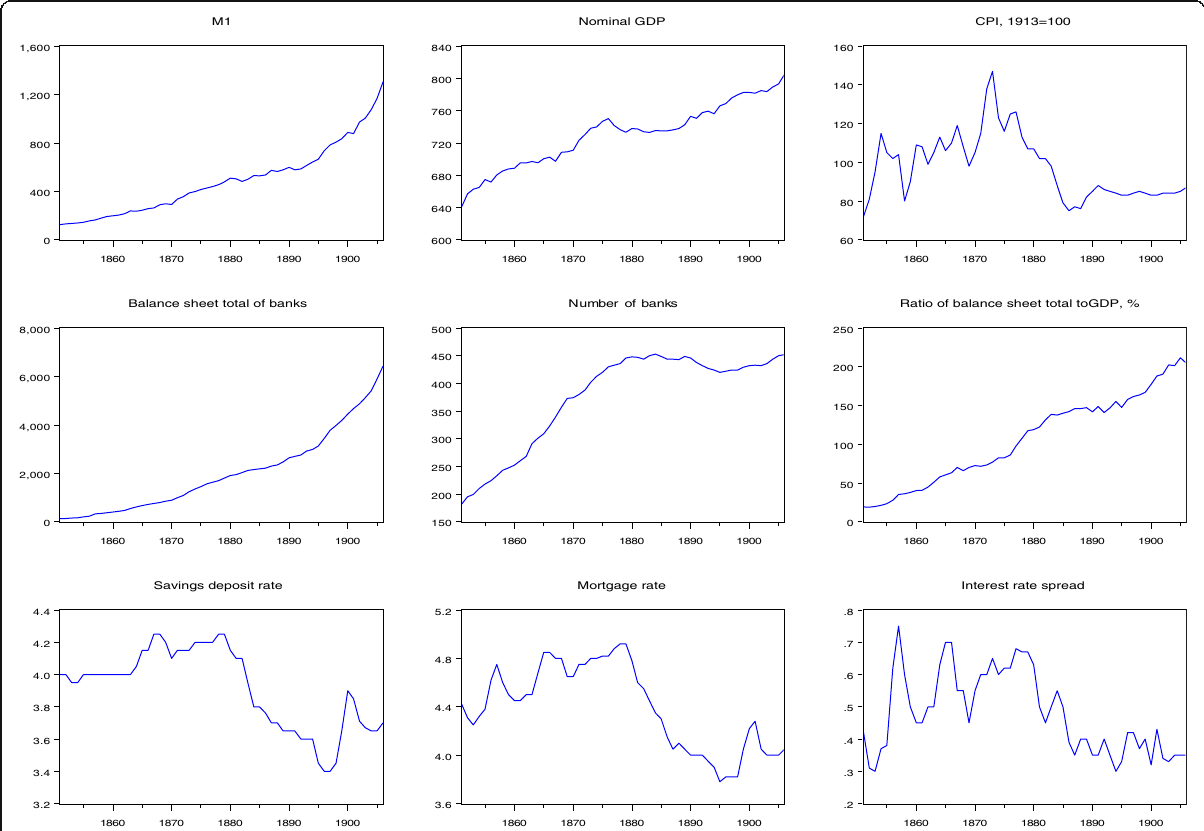
Fig. 2 Data series Swiss money demand estimation, 1851 – 1906. Nominal values in million SFr, interest rates in %. Data source: Swiss economic and social history database: M1 (Table Q3), GDP (Table Q16a, b), number of banks (Q8), and CPI (H17); http://www.fsw.uzh.ch/hstat/hsso/ overview.php. SNB historical series: saving deposit and mortgage interest rates, https://www.snb.ch/de/iabout/stat/statrep/statpubdis/id/ statpub_histz_arch#t3